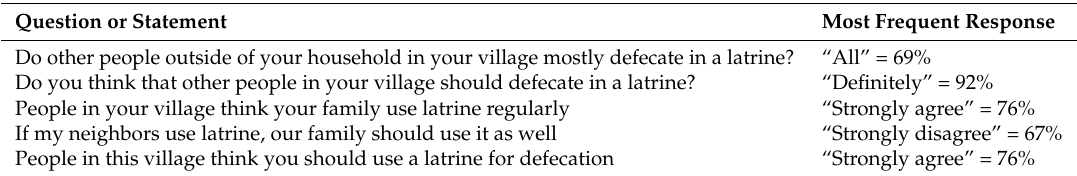
Table 1. Questions and statements used to construct the composite score of